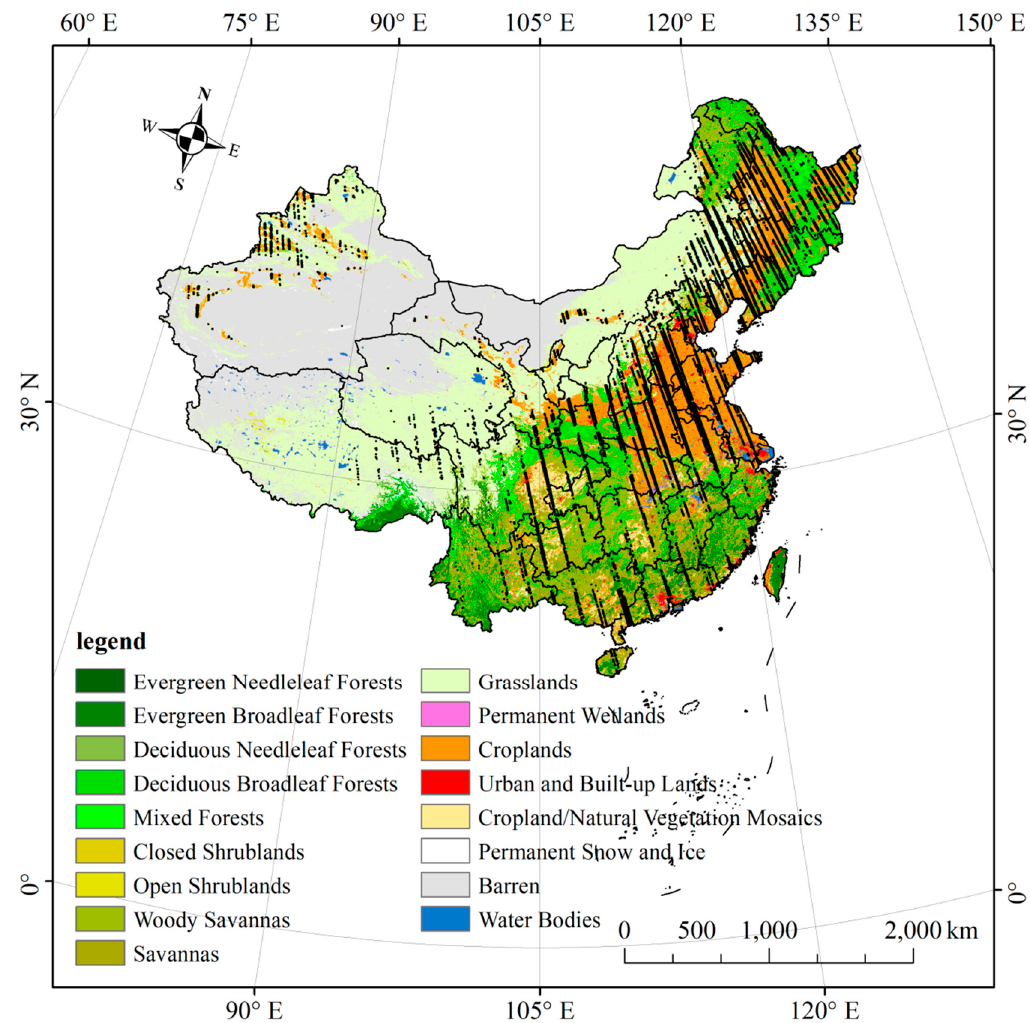
Figure 1. The trajectory of Orbiting Carbon Observatory-2 (OCO-2) passed by cropland from June to August 2015 in China. The land cover map is from the moderate resolution imaging spectroradiometer (MODIS) land cover type product (MCD12Q1) based on the IGBP (International Geosphere-Biosphere Programme) classification scheme.